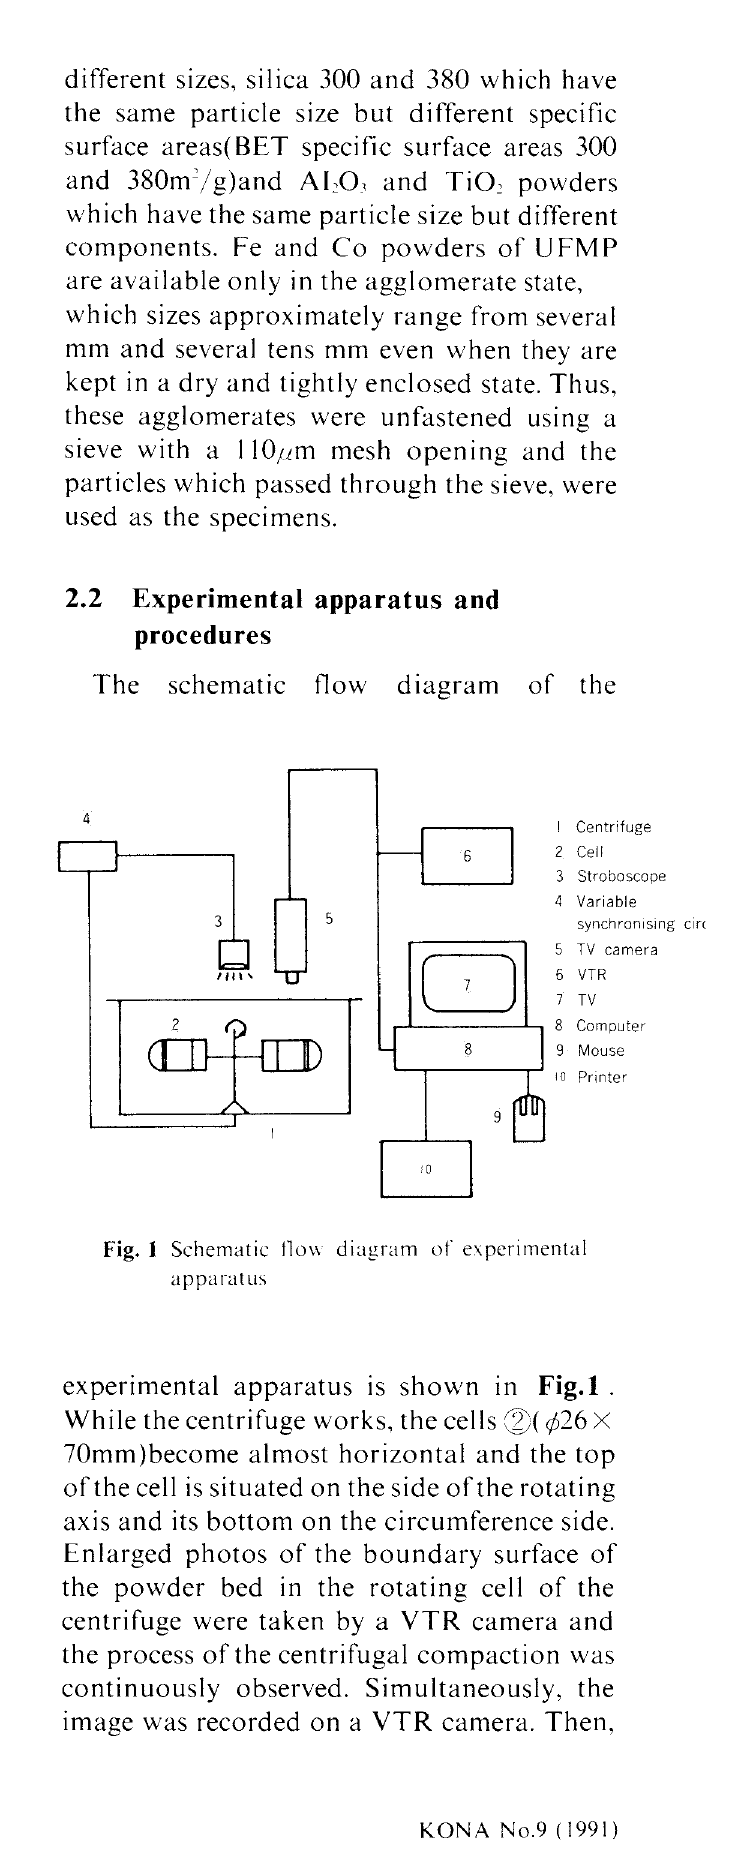
experimental apparatus is shown in Fig.1. While the centrifuge works. the cells Q)( ¢26 X 70mm)become almost horizontal and the top of the cell is situated on the side of the rotating axis and its bottom on the circumference